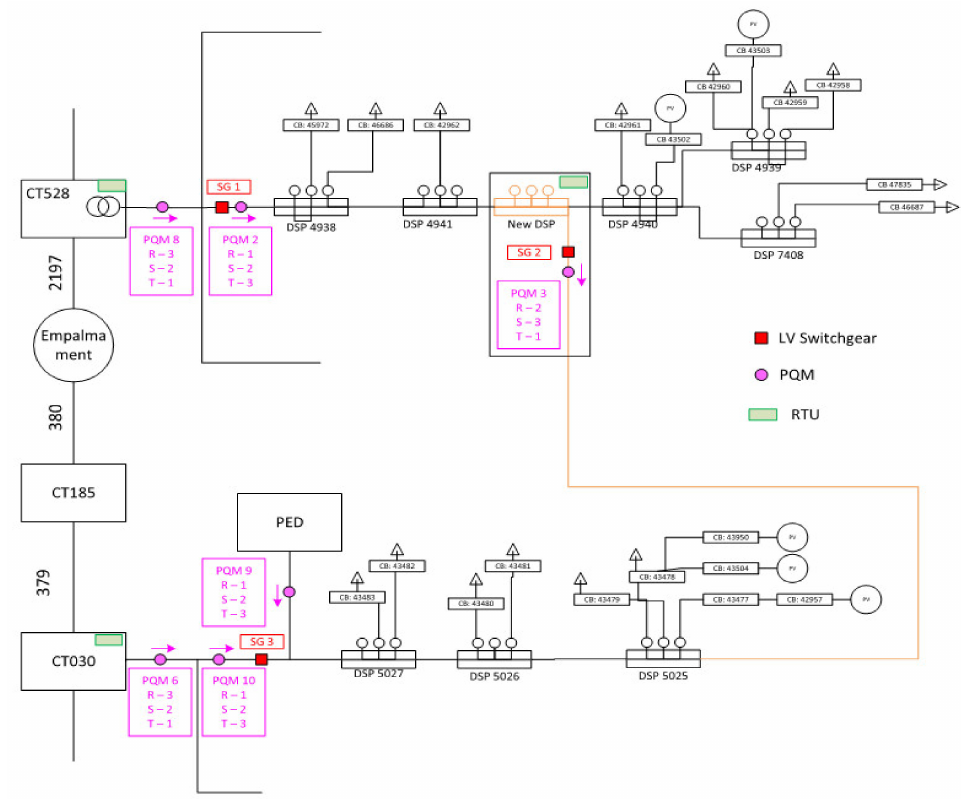
Figure 3. Schematic of the pilot area of RESOLVD.